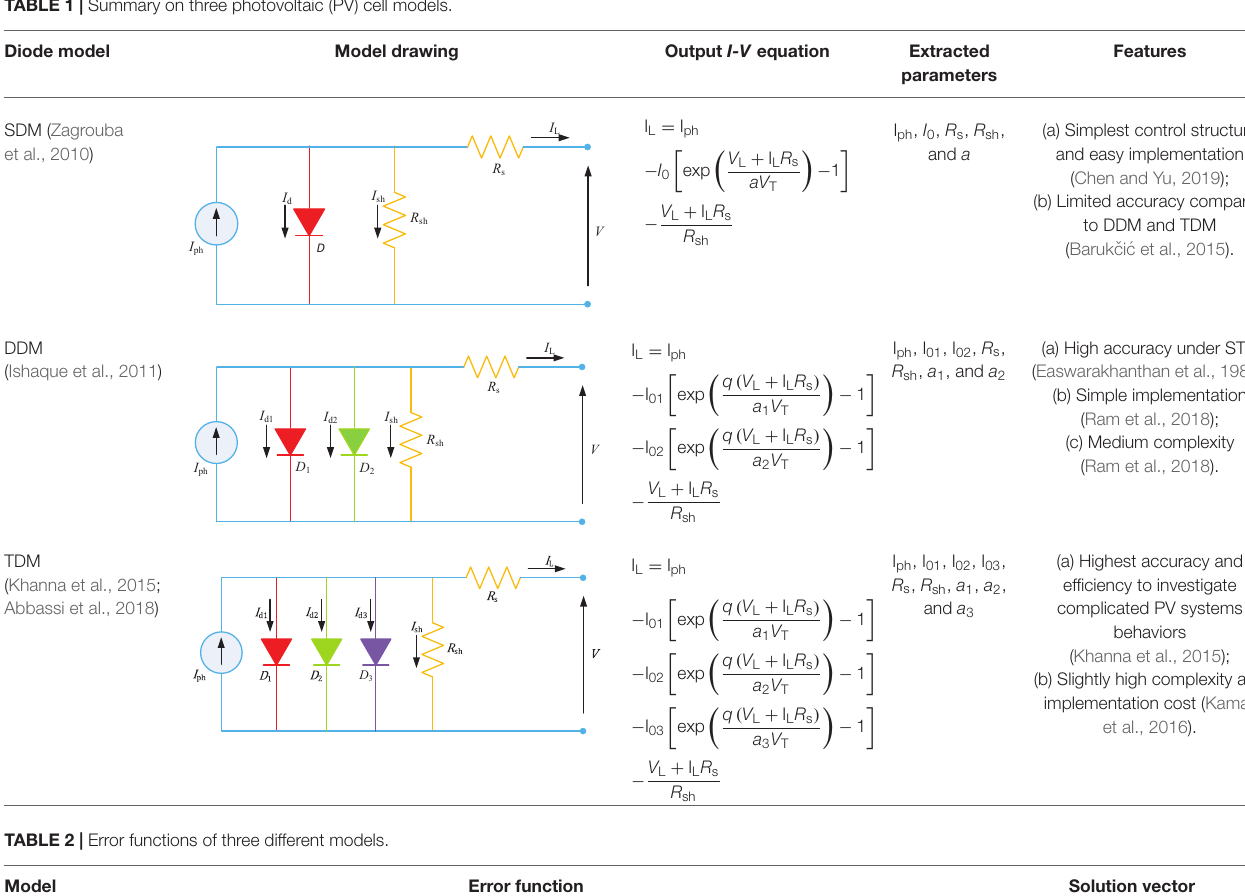
TABLE 1 | Summary on three photovoltaic (PV) cell models.